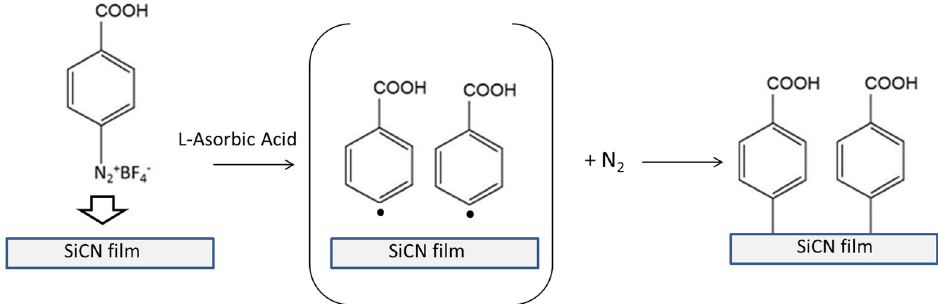
Figure 1. Diagram of diazonium aryl functionalization of SiCN surfaces.